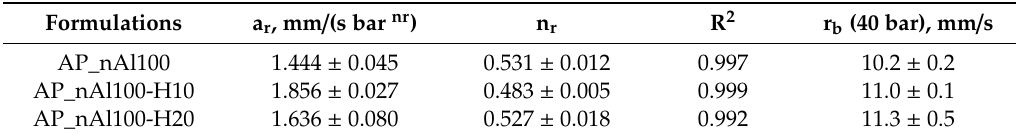
Figure 6. Burning rate of the propellants with aluminum nanopowders. Table 5. Burning rate of the formulations tested.